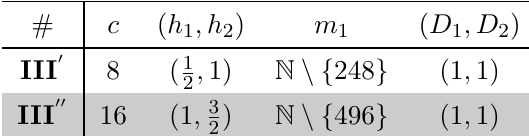
Table 2. Previously uncharacterized infinite familes of admissible character solutions to the (3 , 0) MLDE with c = 8 , 16